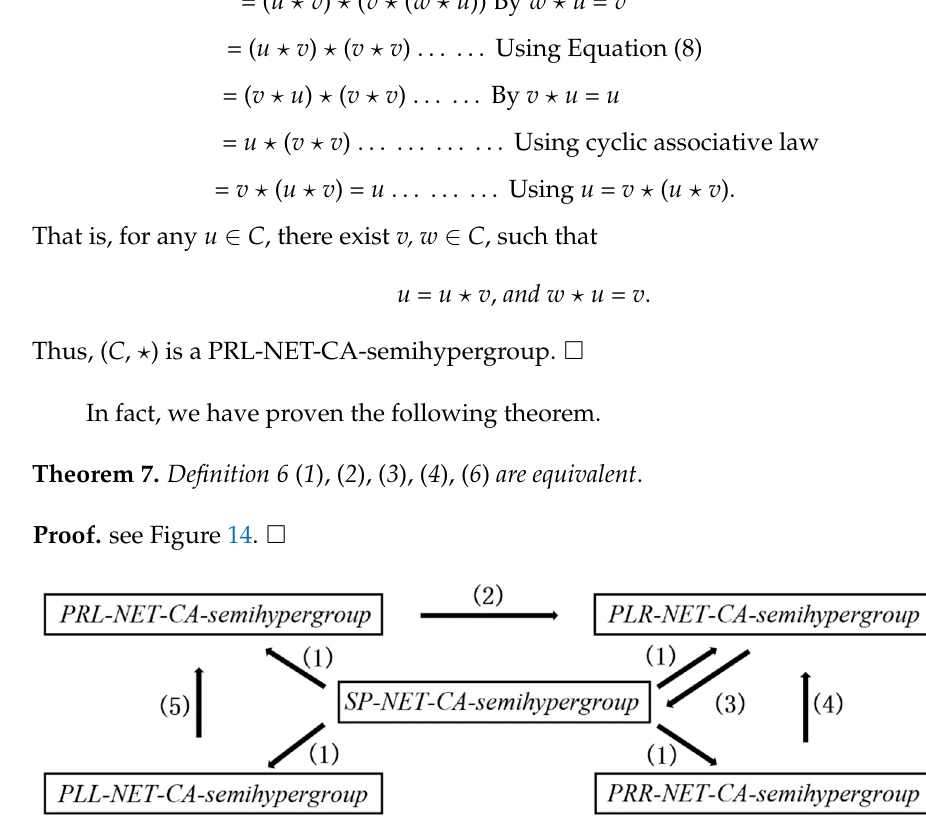
Figure 14. How we proved Theorem 7: Where (1) = Remark 6 ; (2) = Theorem 3 ; (3) = Theorem 4 ; (4) = Theorem 5 ; (5) = Theorem 6